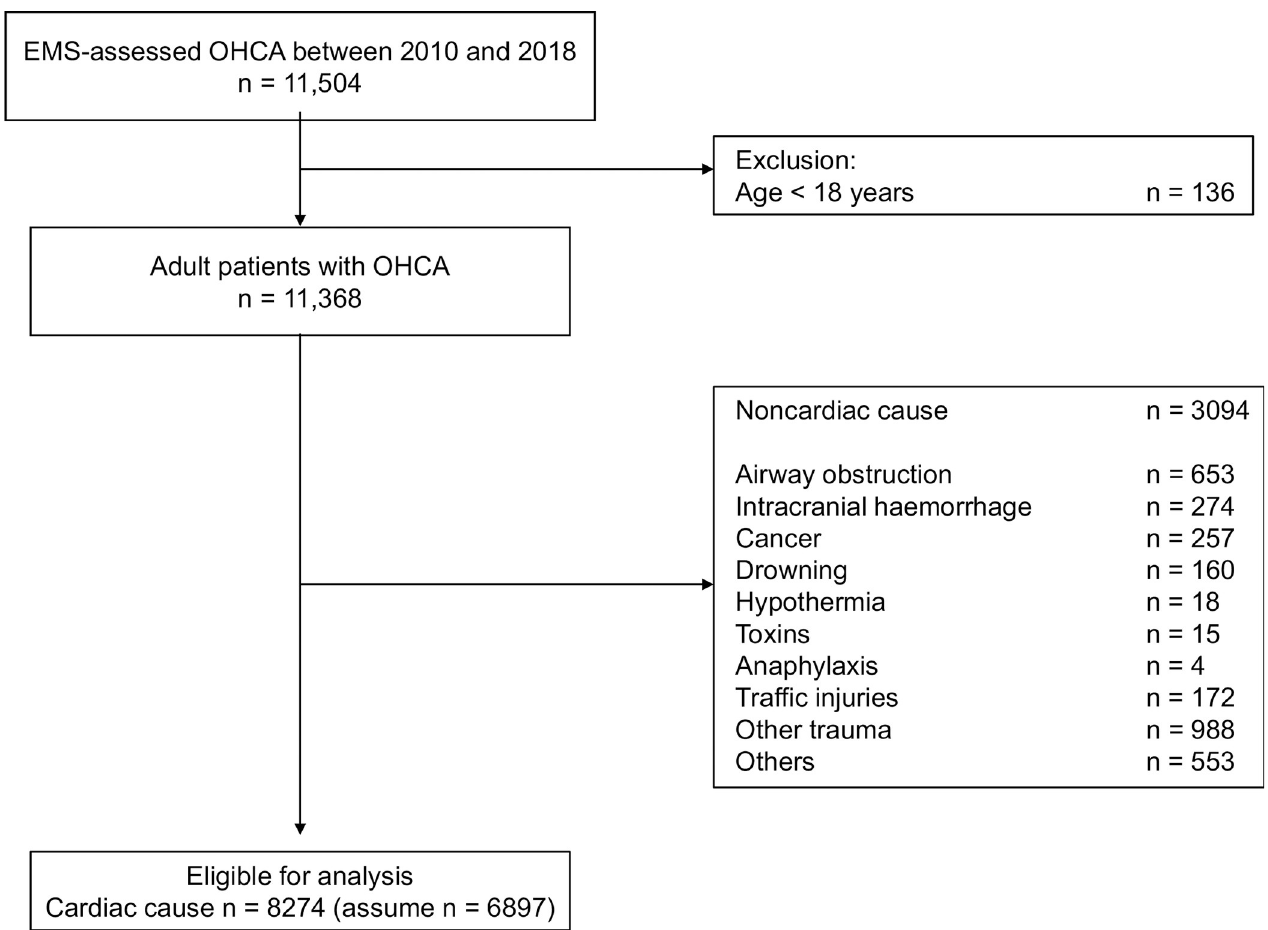
Fig 2. Patient selection flowchart. EMS, emergency medical services; OHCA, out-of-hospital cardiopulmonary arrest.